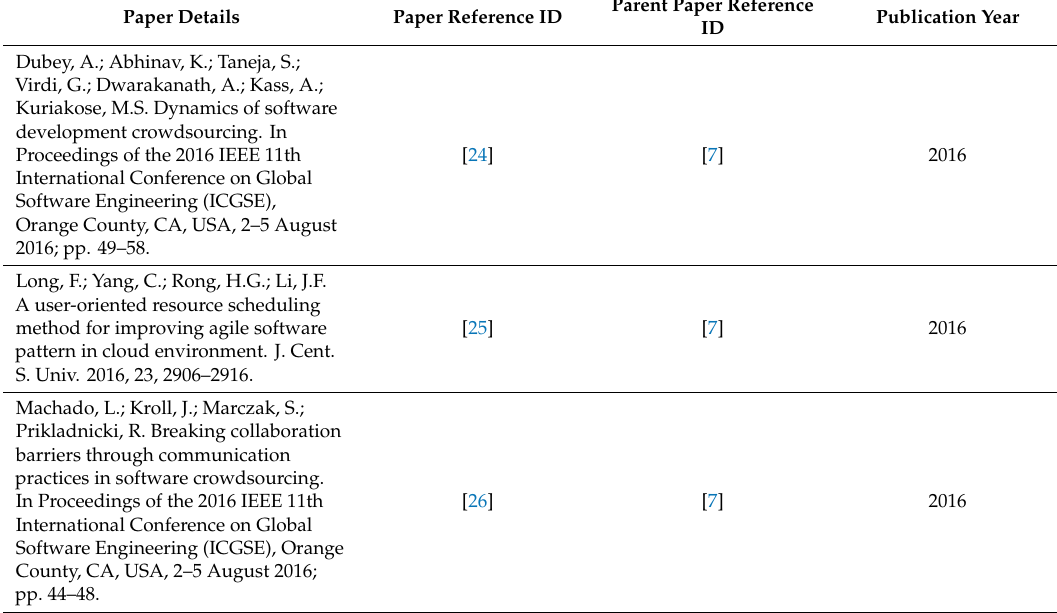
Table 3. Selected Google Scholar citation